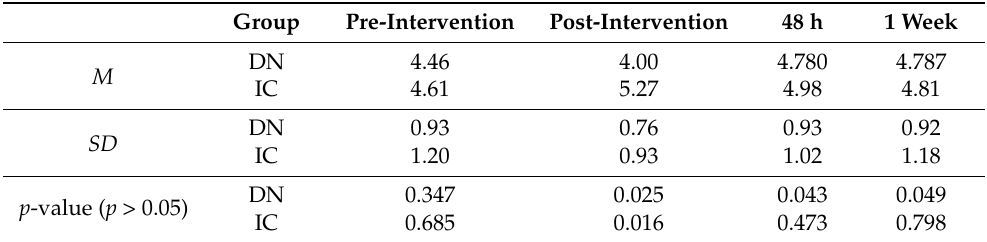
Table 5. Mean (M), standard deviation (SD), and the p -value of algometry, by group and time of measurement. Group Pre-Intervention